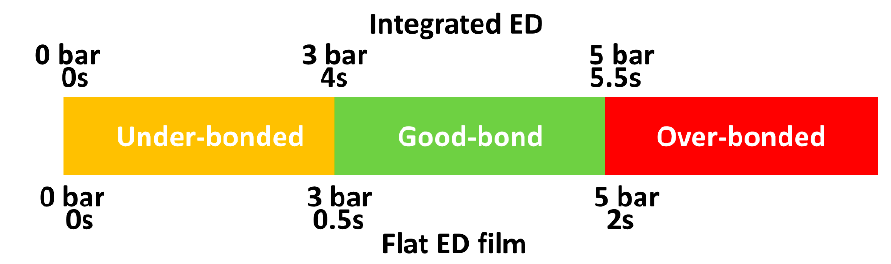
Figure 9. E ff ect of welding parameters on bonding for integrated and flat ED composites. Figure 9. Effect of welding parameters on bonding for integrated and flat ED composites.